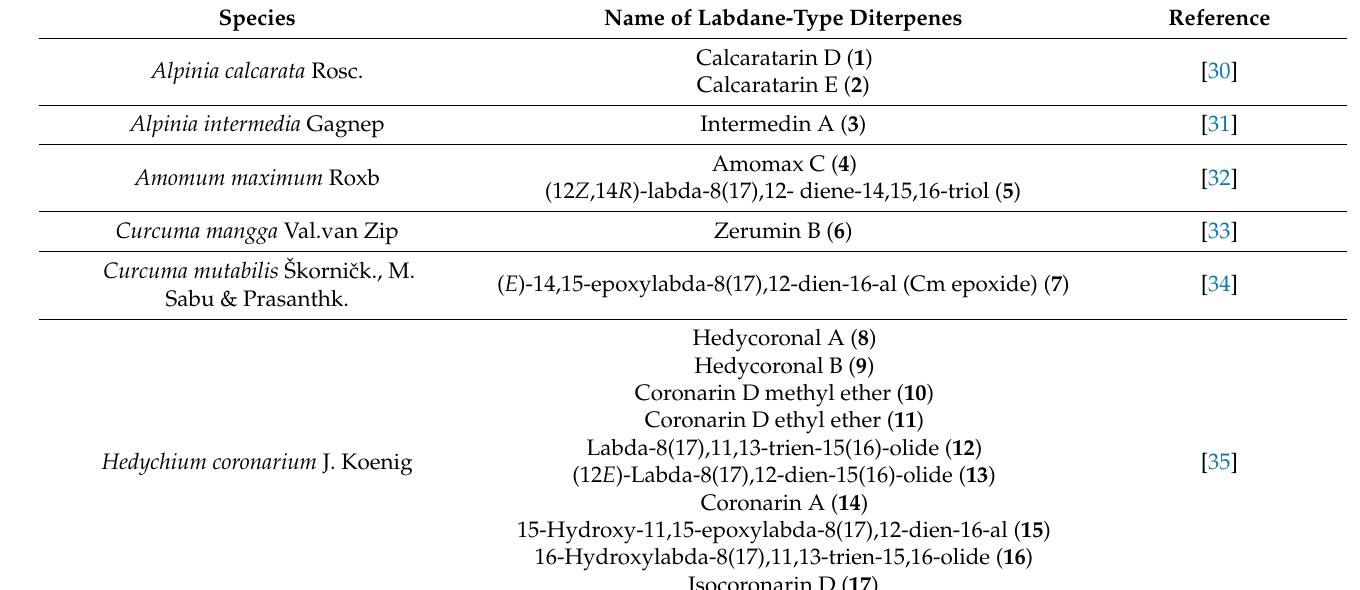
Table 3. Cytotoxic labdane-type diterpenes from the Zingiberaceae.